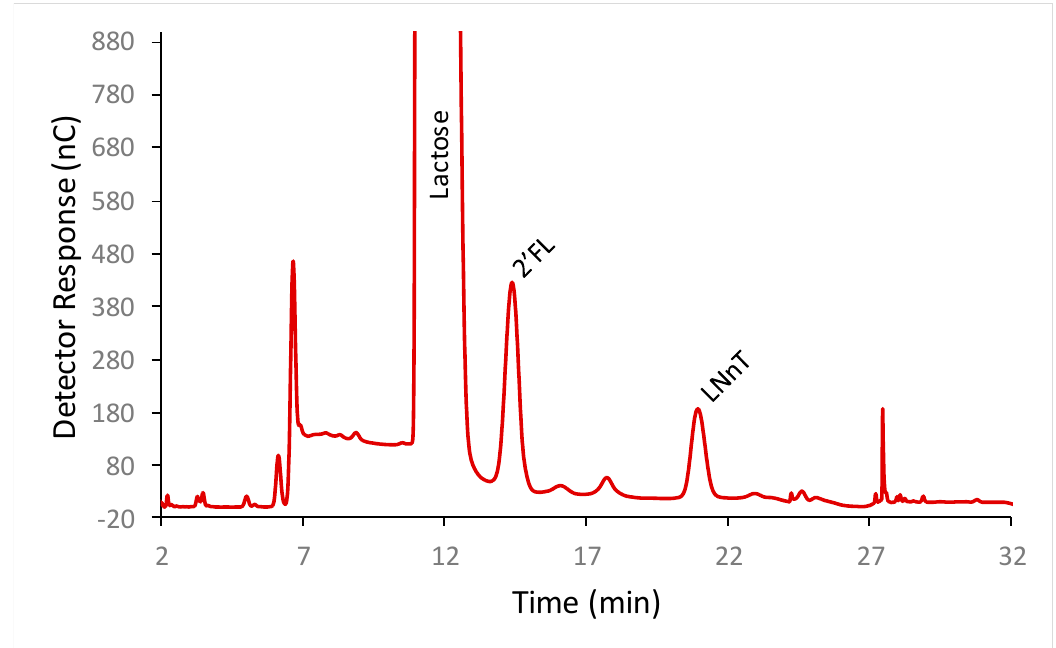
Figure 1 . Separation of 2 ′ -fucosyllactose (2 ′ -FL) and Lacto-N-neotetraose (LNnT) from each other and from lactose in infant formula by high performance anion exchange chromatography with pulsed amperometric detection (HPAEC-PAD).